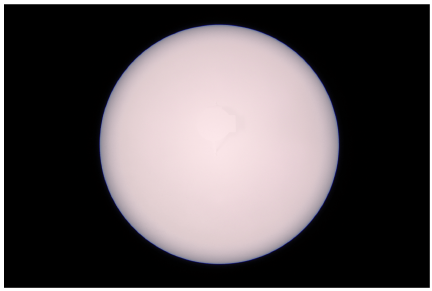
Figure 3. Reference image captured inside the uniformly illumi- nated integrating sphere.